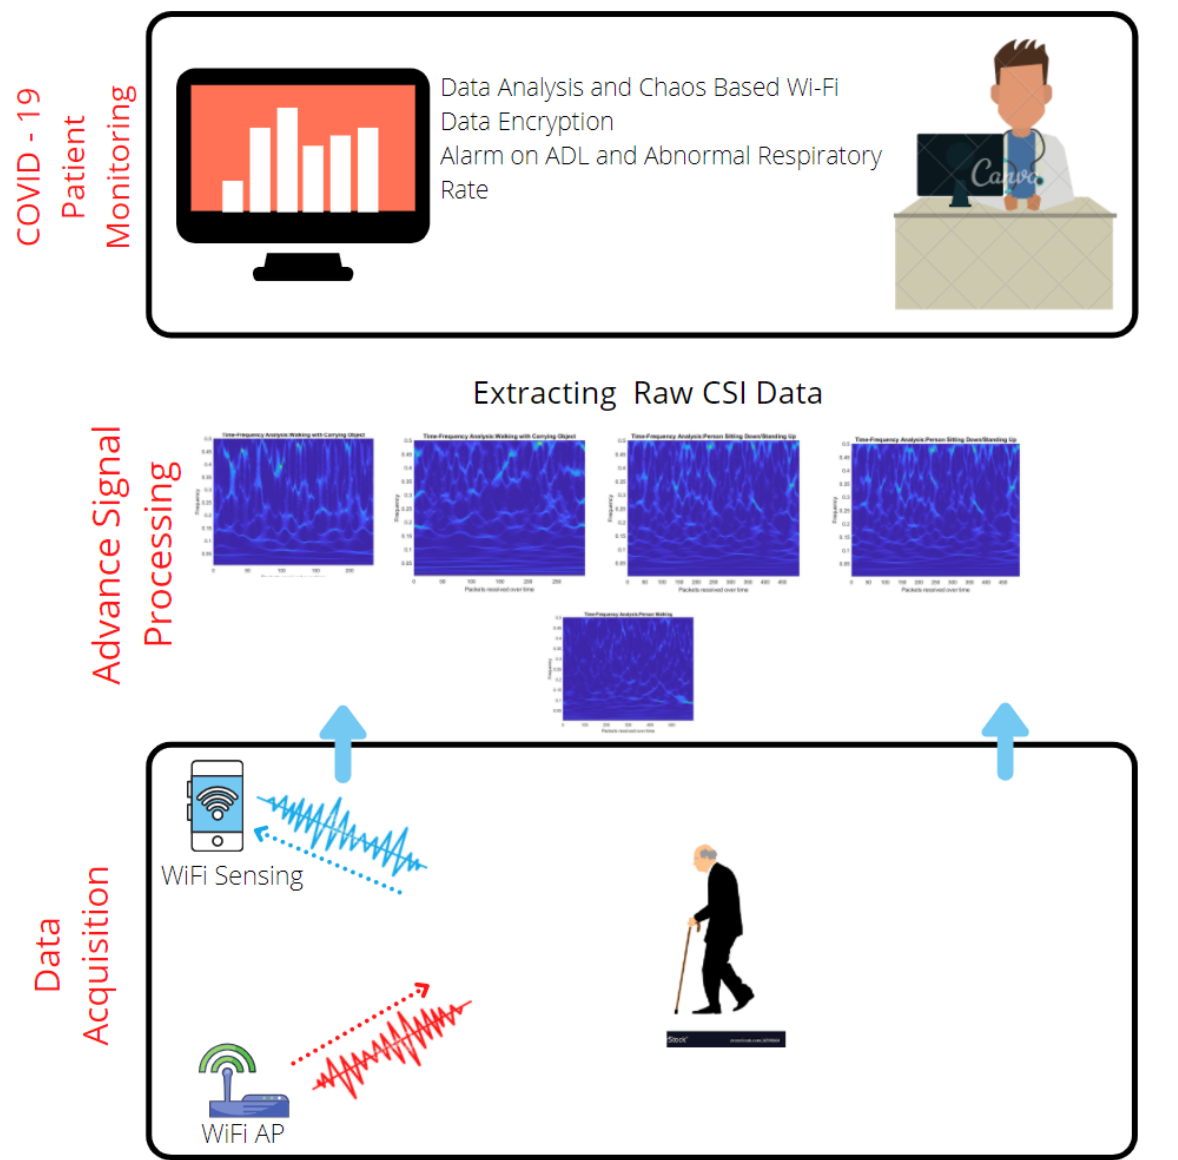
Figure 1. Data collection and data analysis using WiFi sensing. The raw variations of the amplitude information of the CSI data for different activities of daily living are presented in Figure